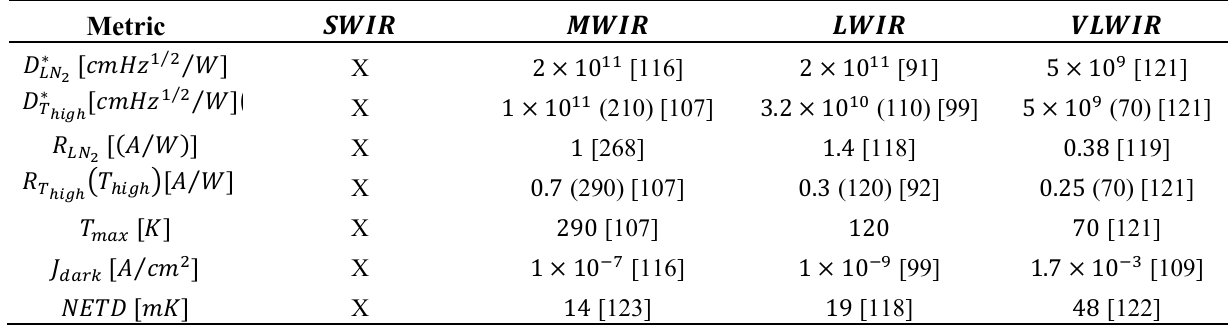
Table 3. Highest reported performance metrics for QWIPs across different wavelength regimes. Metric